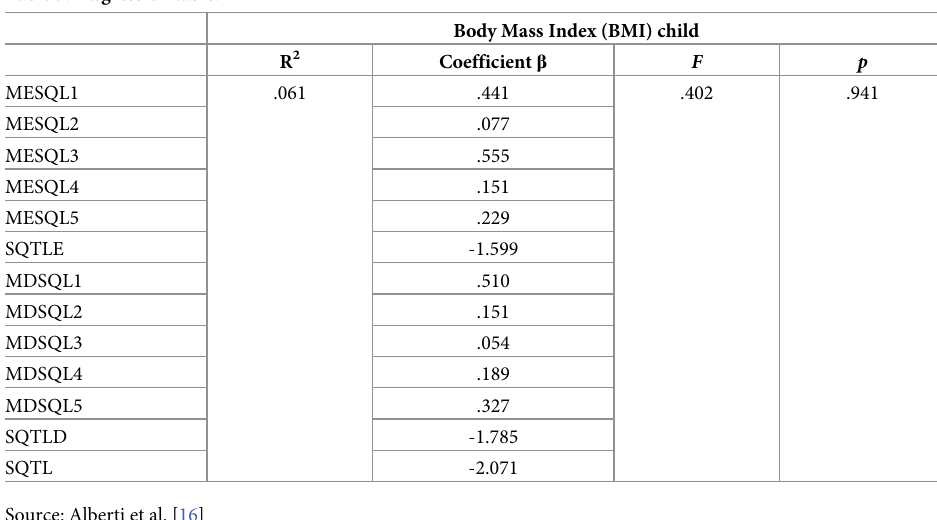
Table 7. Regression